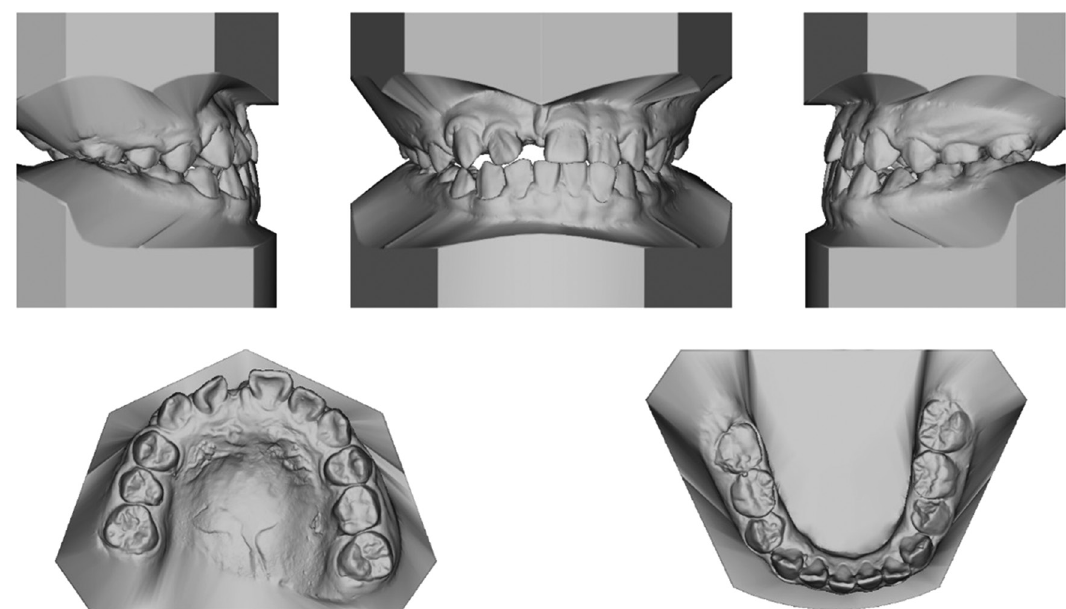
Figure 2. Pre-treatment dental casts.